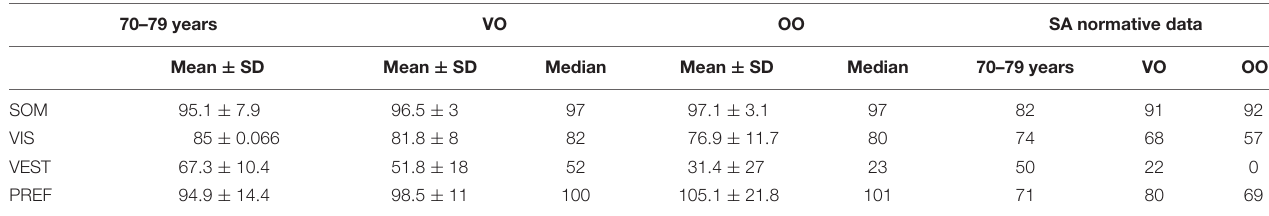
TABLE 4 | Sensory analysis (SA) descriptive (mean ± SD, median) and normative data for three age groups: 70–79 years (data provided by NeuroCom R (cid:13) International Inc., 2003), very old (VO, 80–84 years), and oldest old (OO, 85–89 years).